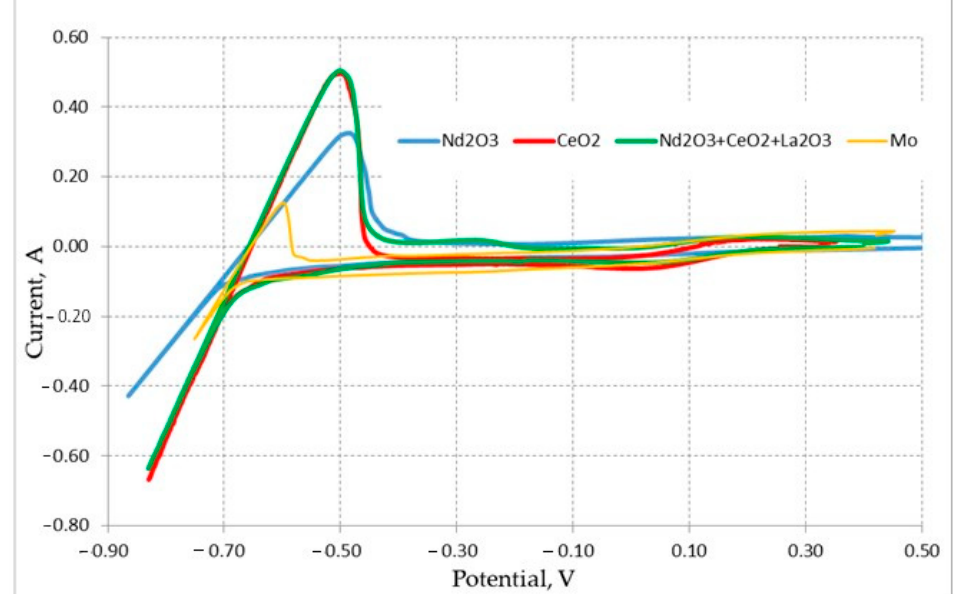
Figure 2. Cyclic voltammograms of REM pellets located on the Mo electrode recorded in the LiCl—Li 2 O (0–0.8 wt.%) melt at 650 ° С . The scan rate was 0.01 V/s. The Bi-Li reference electrode was used (0.655 V relative Li + /Li).